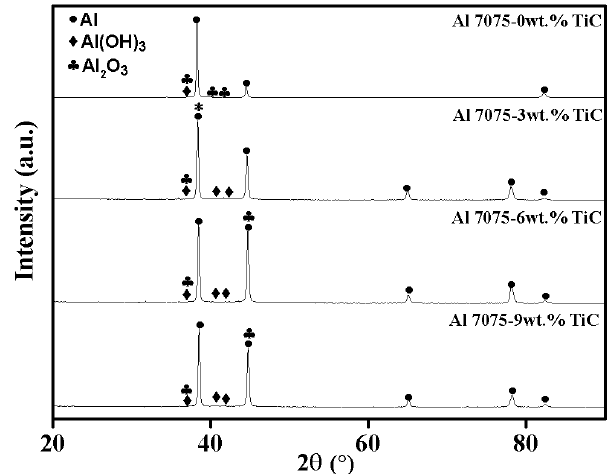
Fig. 18. XRD patterns of Corroded samples of Al 7075 alloy and the composites with different weight percent of TiC.